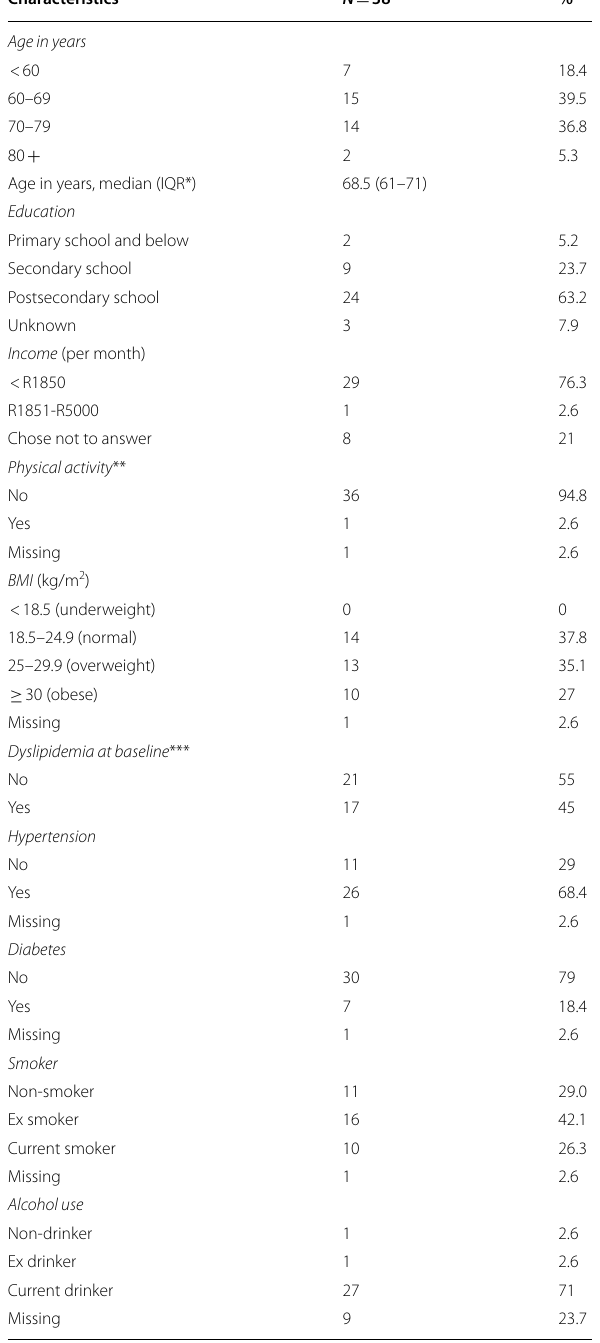
Table 2 Demographic characteristics of